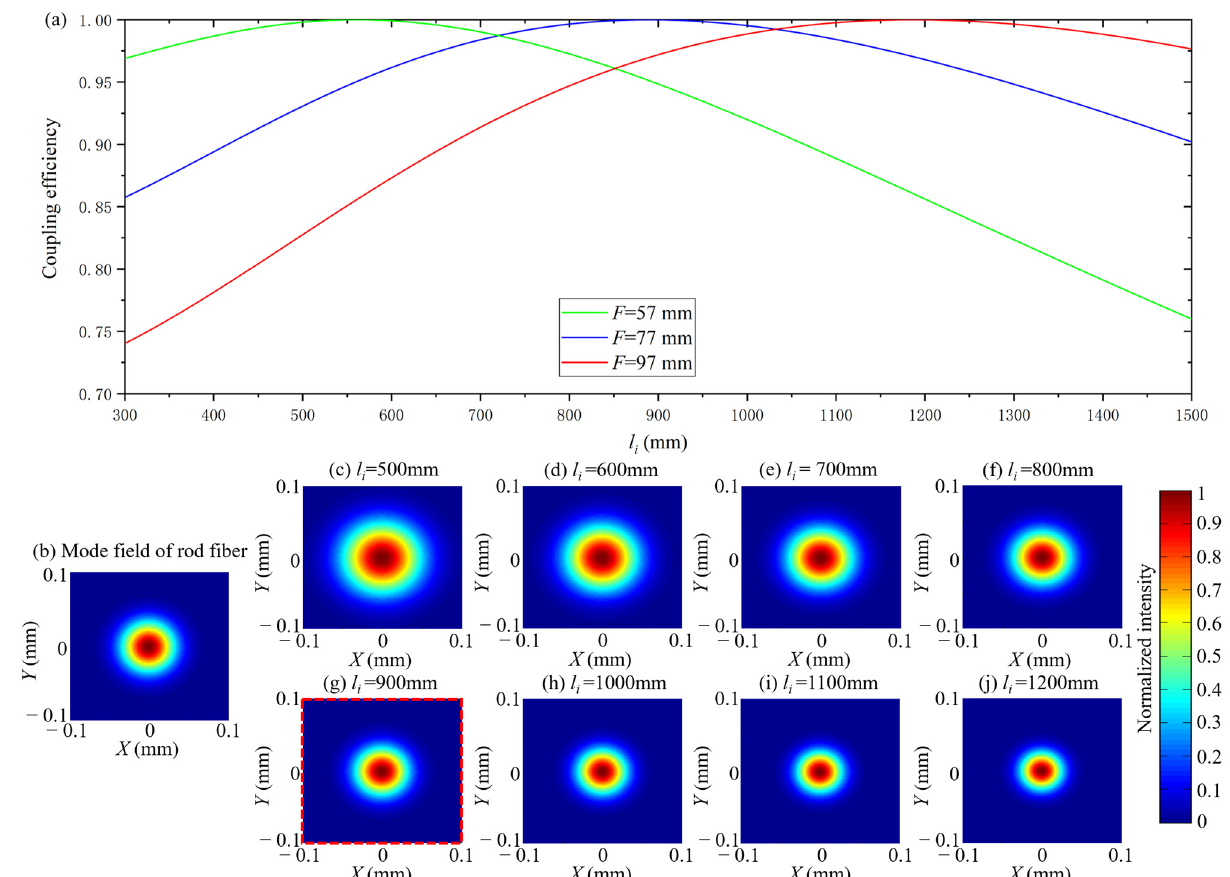
l with different F when o